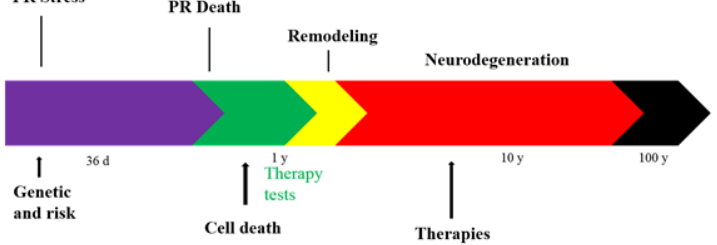
Figure 4. Diagram of the timeline of retina degeneration. PR: Photoreceptor. 754